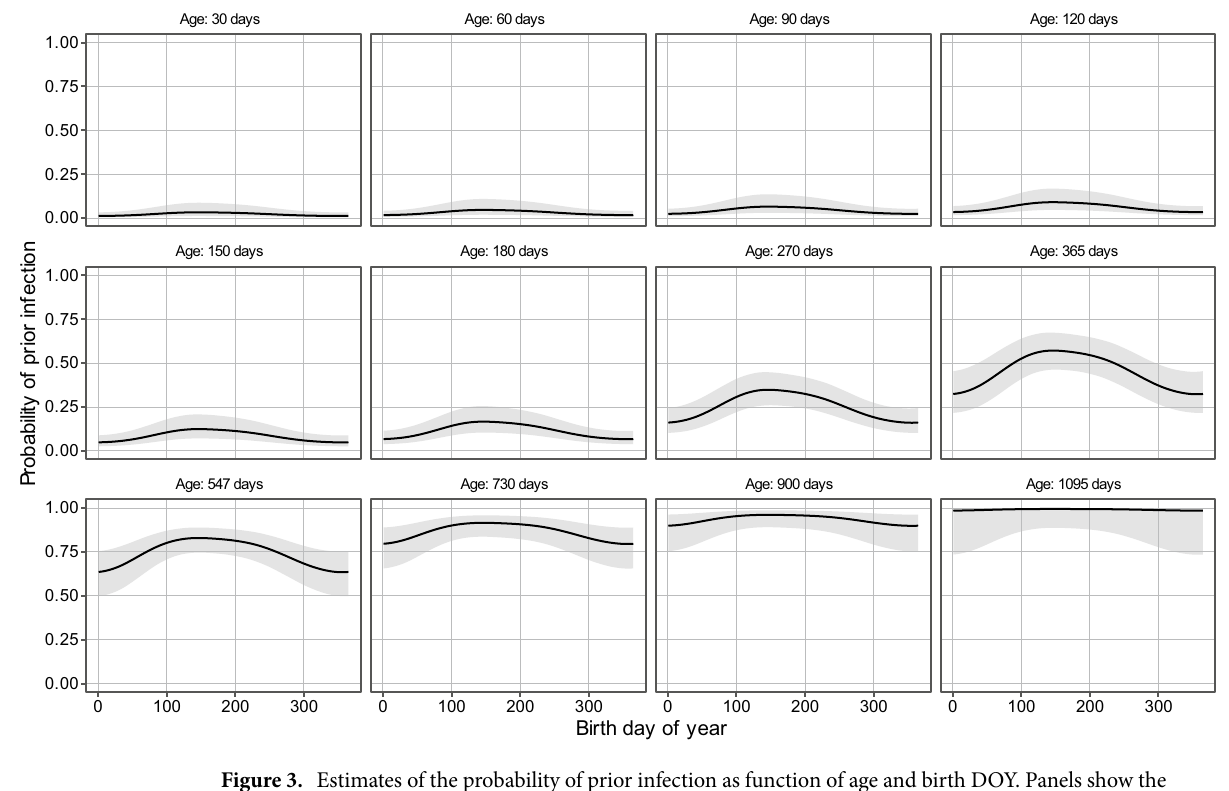
Figure 3. Estimates of the probability of prior infection as function of age and birth DOY. Panels show the estimated probability of prior infection as function of birth DOY within the years for various ages (baseline model). Shaded areas represent 95% confidence envelopes. See Supplement Figure 4 for additional results.